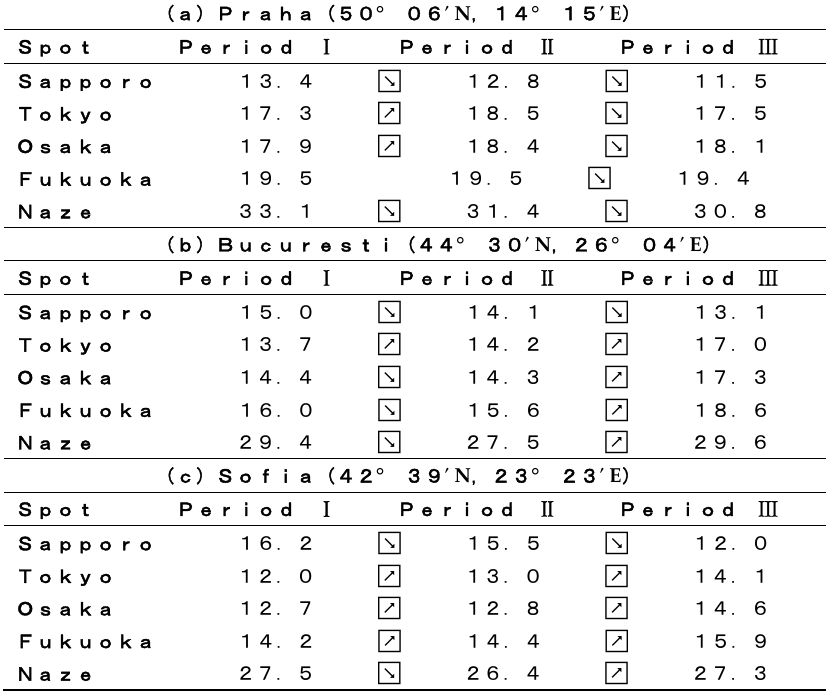
Table 8. The sequence of the cross angle of the monthly distributions of temperatures between three East-European and the five Japanese stations.